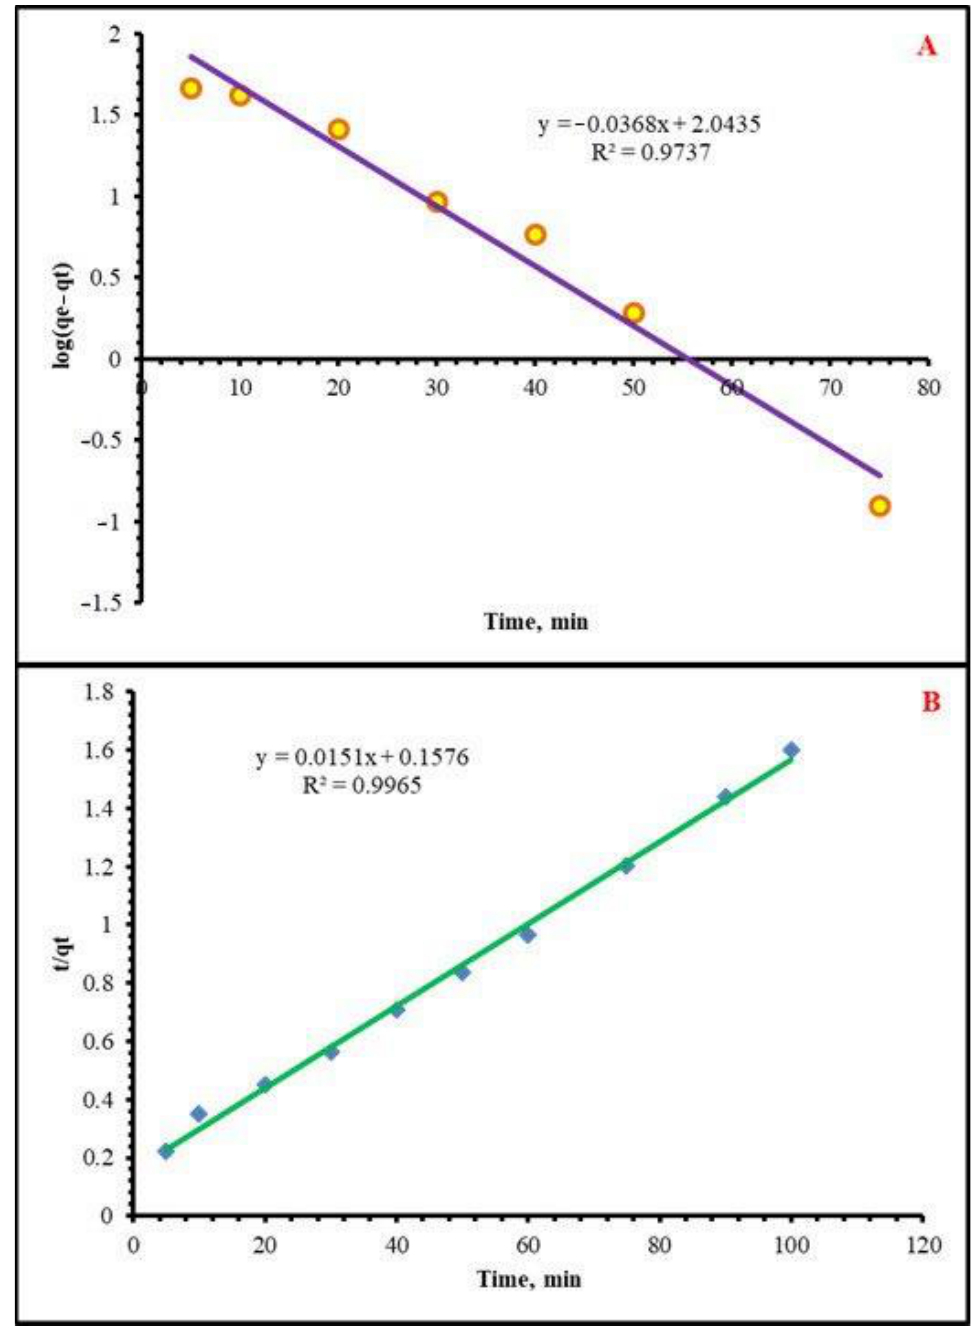
Table 2. Kinetic parameters of W(VI) ions adsorbed on HNAP/QA.